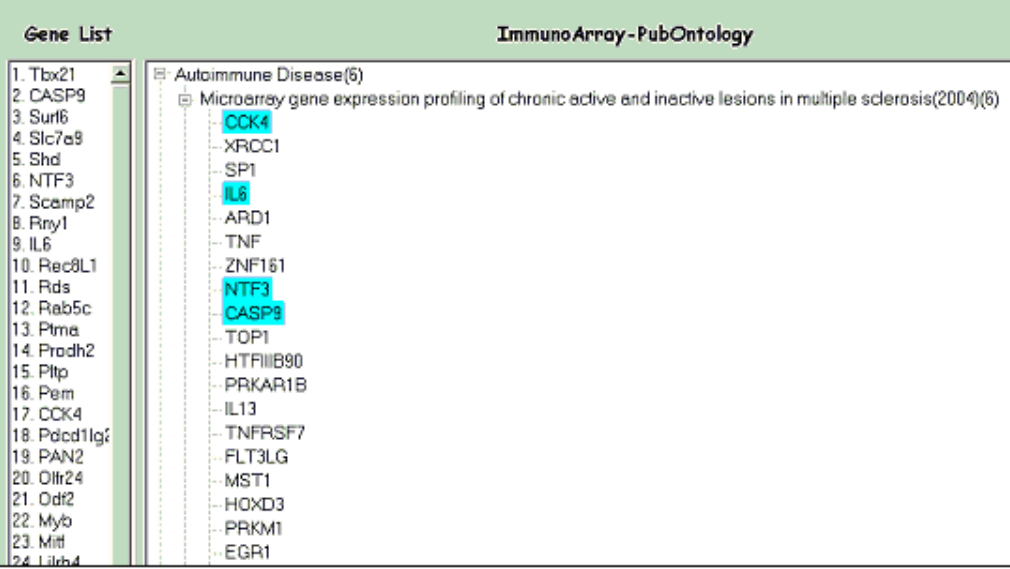
Figure 4. Hierarchical structure of the